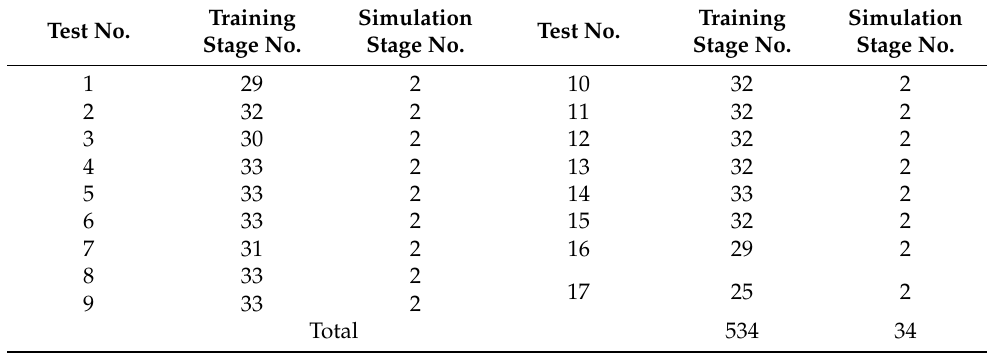
Table 3. Datasets distribution between the training and simulation stages for all tests. Test No.